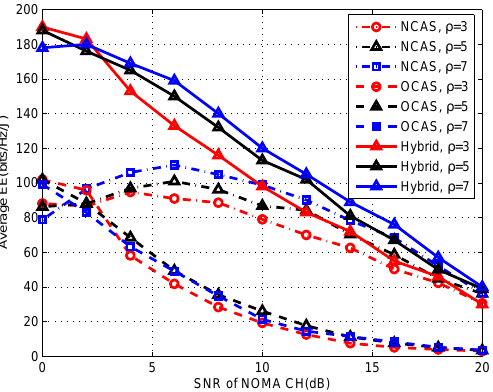
Figure 9. Comparison of average energy efficiency (EE) among the hybrid NOMA-OFDMA, NCAS, and OCAS, ρ = 3, 5 and 7 dB, U = 60.